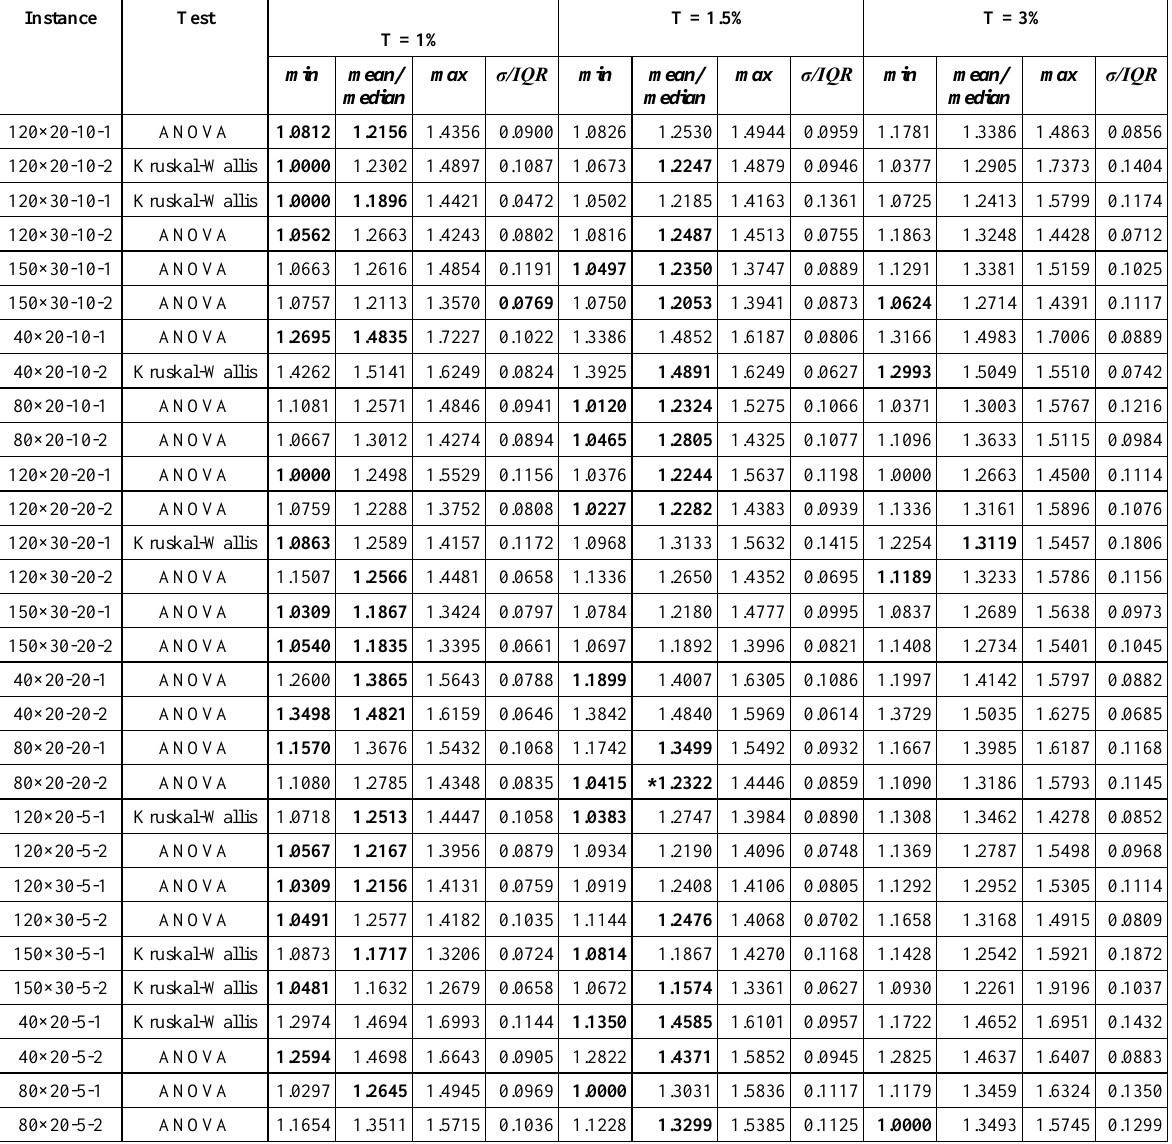
Table 3. Results of the spread metric for each